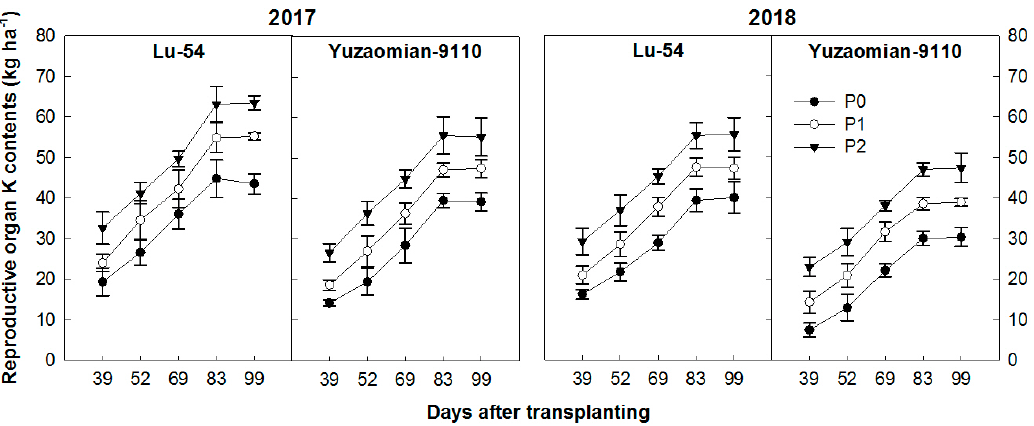
Figure 5. The accumulation of total K contents (kg ha − 1 ) in reproductive organ of cotton plant for Lu-54 and Yuzaomian-9110 in 2017 and 2018. The treatments P0, P1, and P2 represent the P levels, i.e., 0, 100, and 200 kg P 2 O 5 ha − 1 . The data are the means of three replications ± standard error.